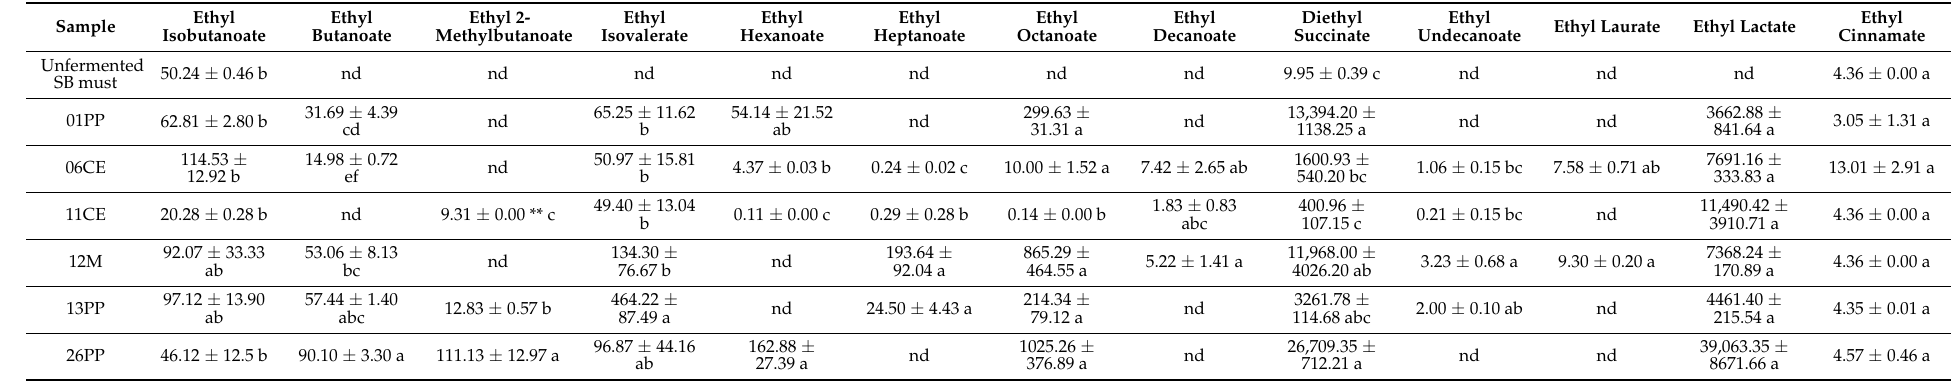
Table 3. Concentration of ethyl esters ( µ g/L) in unfermented and fermented Sauvignon Blanc musts. Means ± standard error, followed by the same letter, do not differ according to Tukey’s test considering a 0.05 significance